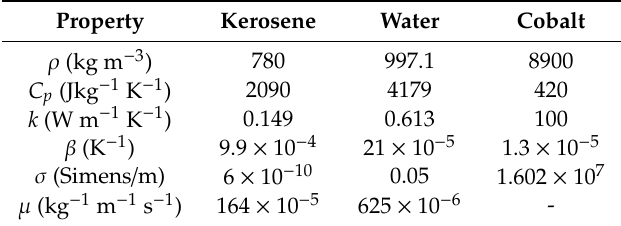
Table 1. Thermophysical properties of kerosene, water and cobalt